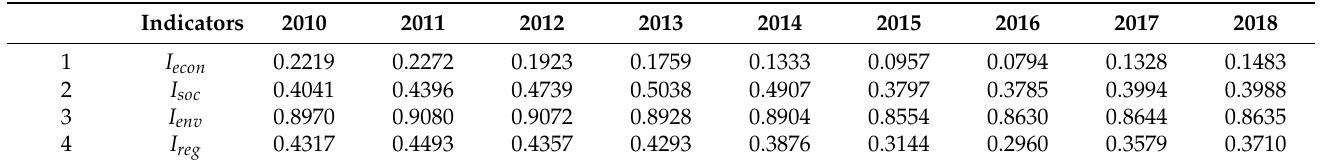
Table 4. Aggregated and composite indicators of the Republic of Buryatia from 2010–2018.